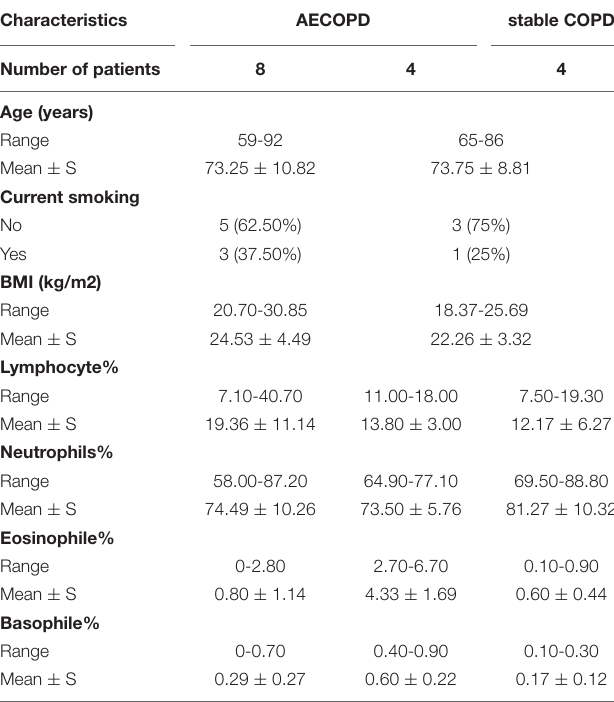
TABLE 1 | Background information for the acute exacerbation of chronic obstructive pulmonary disease (AECOPD) and stable chronic obstructive pulmonary disease (COPD)